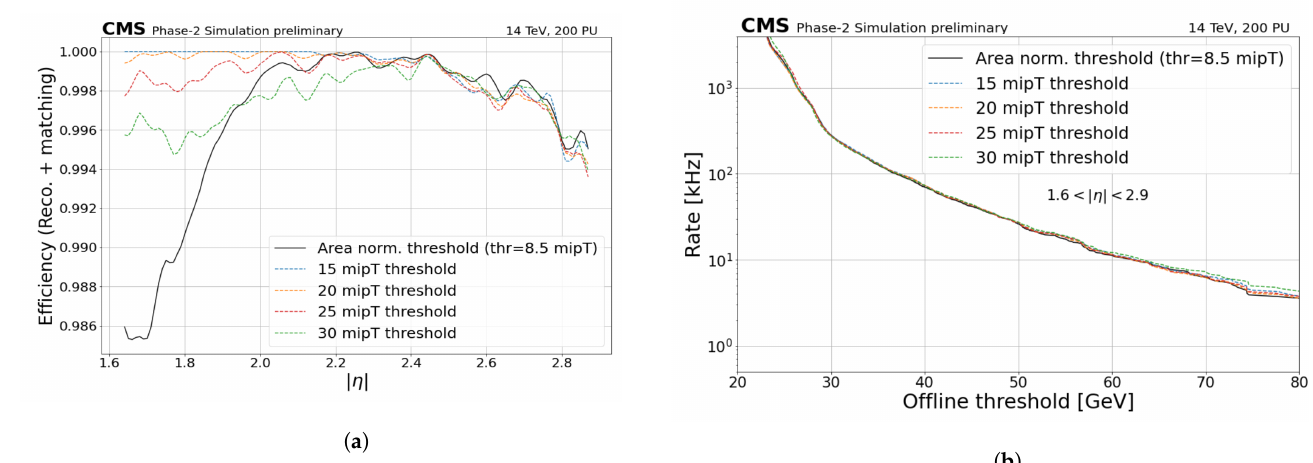
Figure 7. Impact of the seeding energy threshold definition on the e / γ cluster performance. The black lines show the performance achieved with an | η | -dependent area-weighted threshold, while the dashed-colored lines illustrate the performance obtained with constant thresholds. ( a ) Cluster reconstruction efficiency as a function of | η | . The | η | range is reduced with respect to the HGCAL acceptance to remove possible border effects ( b ) trigger rate as a function of the offline threshold on the reconstructed object’s p T